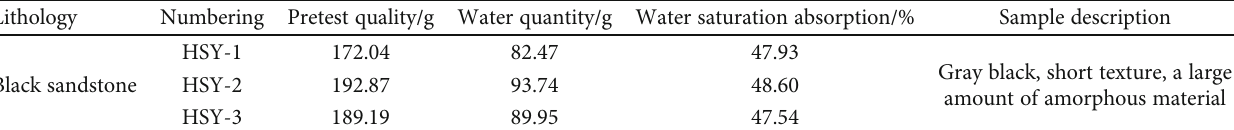
Table 1: Statistical table of water absorption characteristics of the black sandstone. Lithology